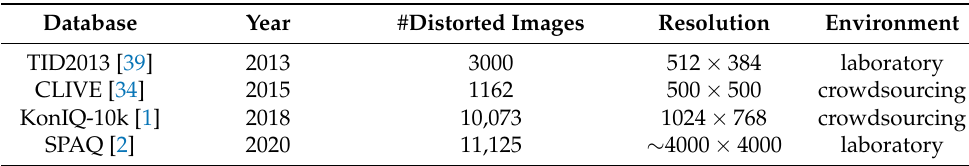
Table 1. Publicly available IQA benchmark databases used in this